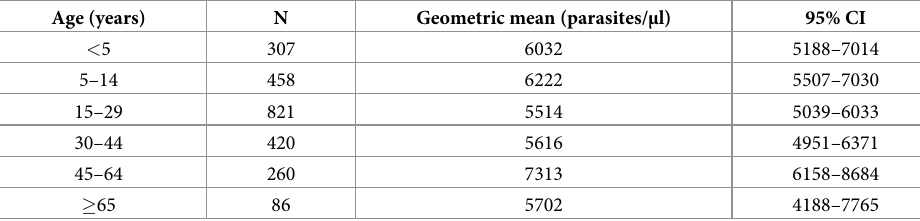
Table 1. Distribution of parasite density levels in severe malaria according to age in Colombia, 2014–2017.